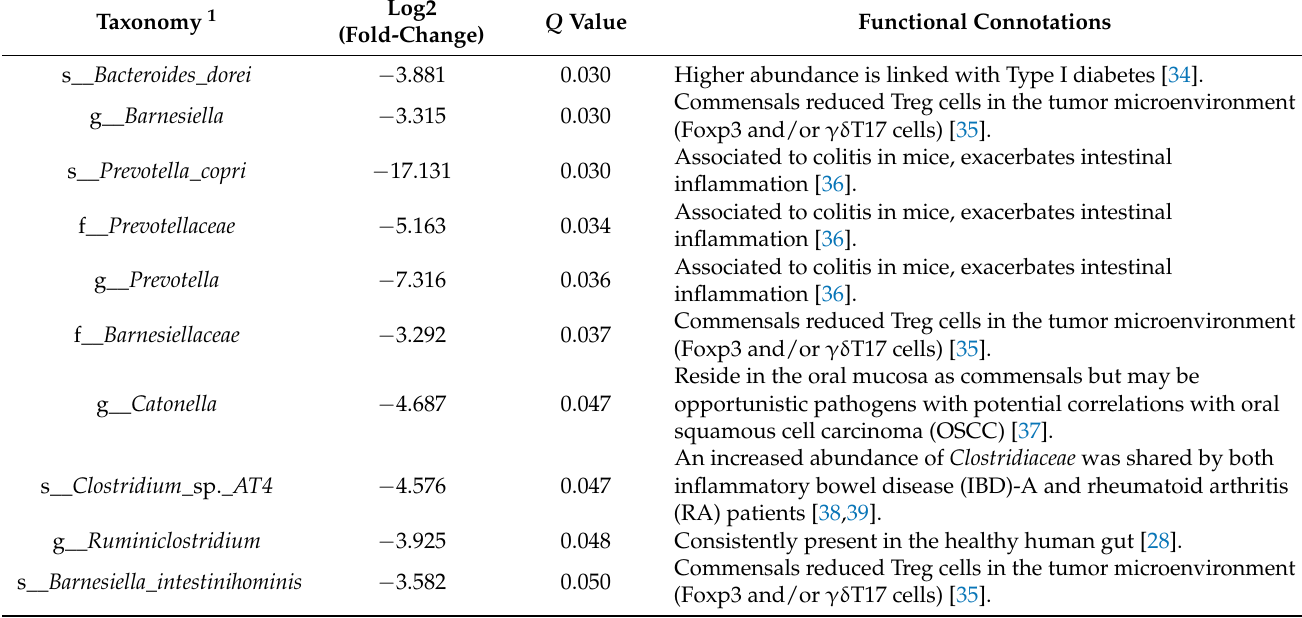
Table 6. Day 15 comparison of the taxonomic abundance of subjects demonstrating UV resistance following grape consumption on Days 30 and 60 ( n = 3) vs. subjects not resistant to UV irradiation following grape consumption ( n =